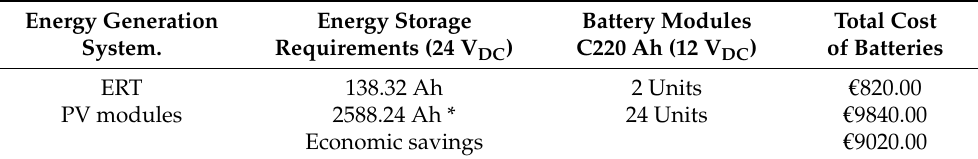
Table 3. Economic savings in energy storage capacity costs for equivalent ERT and PV generators for public lighting